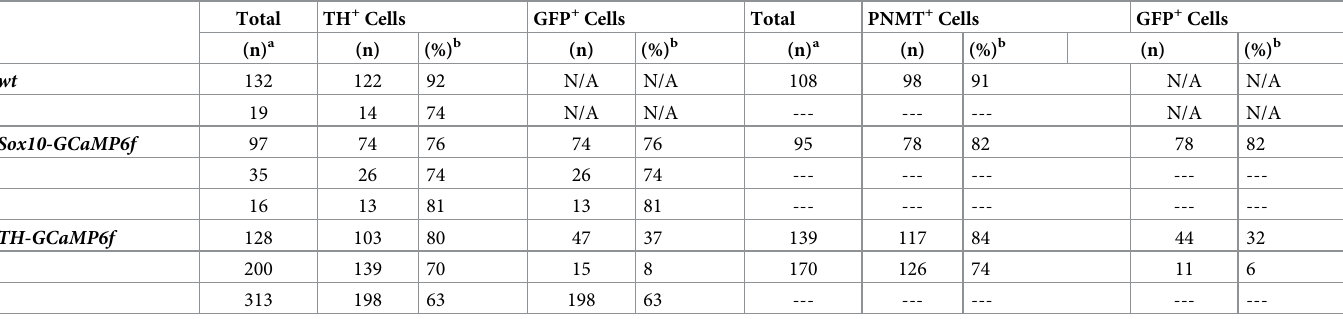
Table 1. Immunocytochemical characterization of wt and transgenic mouse adrenal medullary